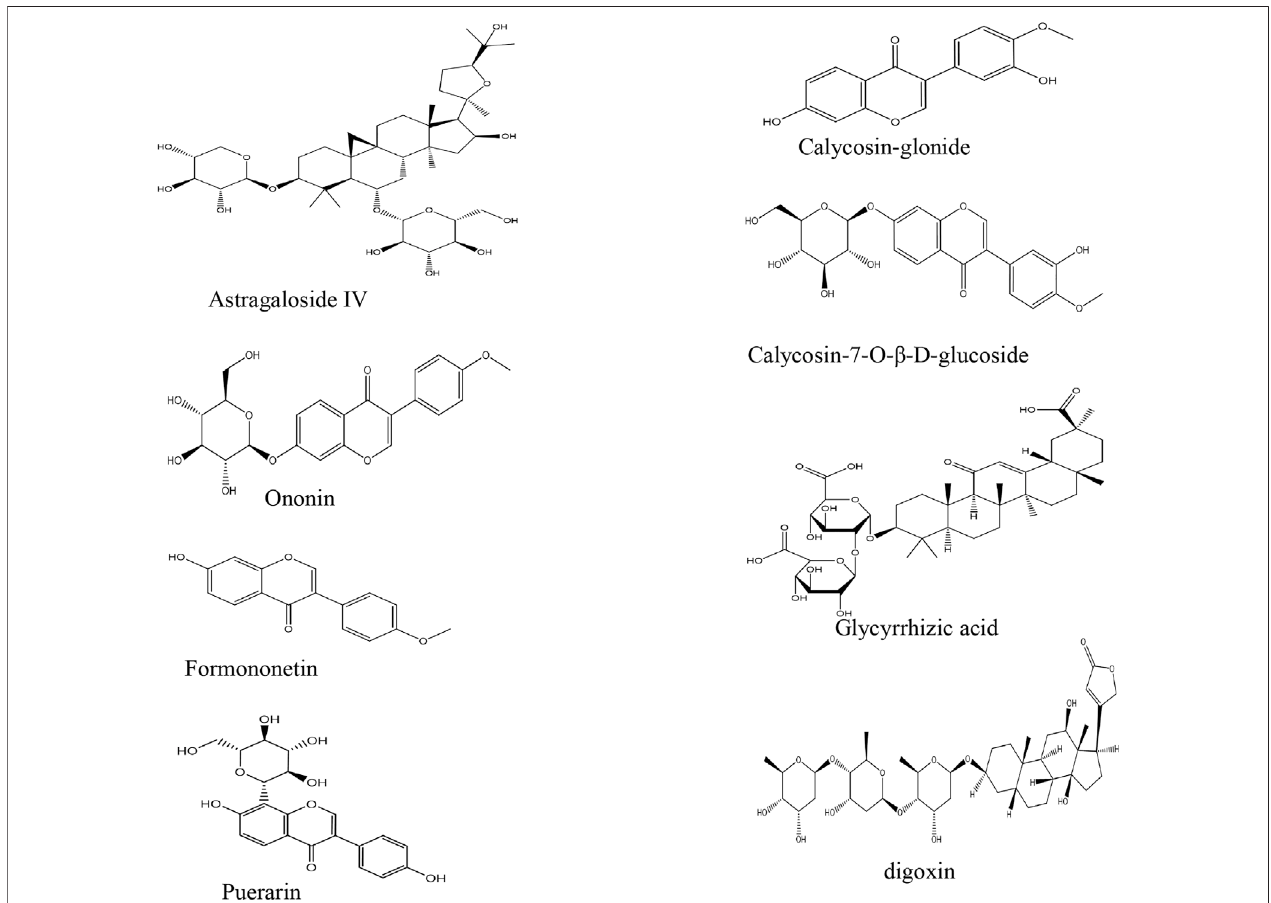
FIGURE 1 | The chemical structure of six